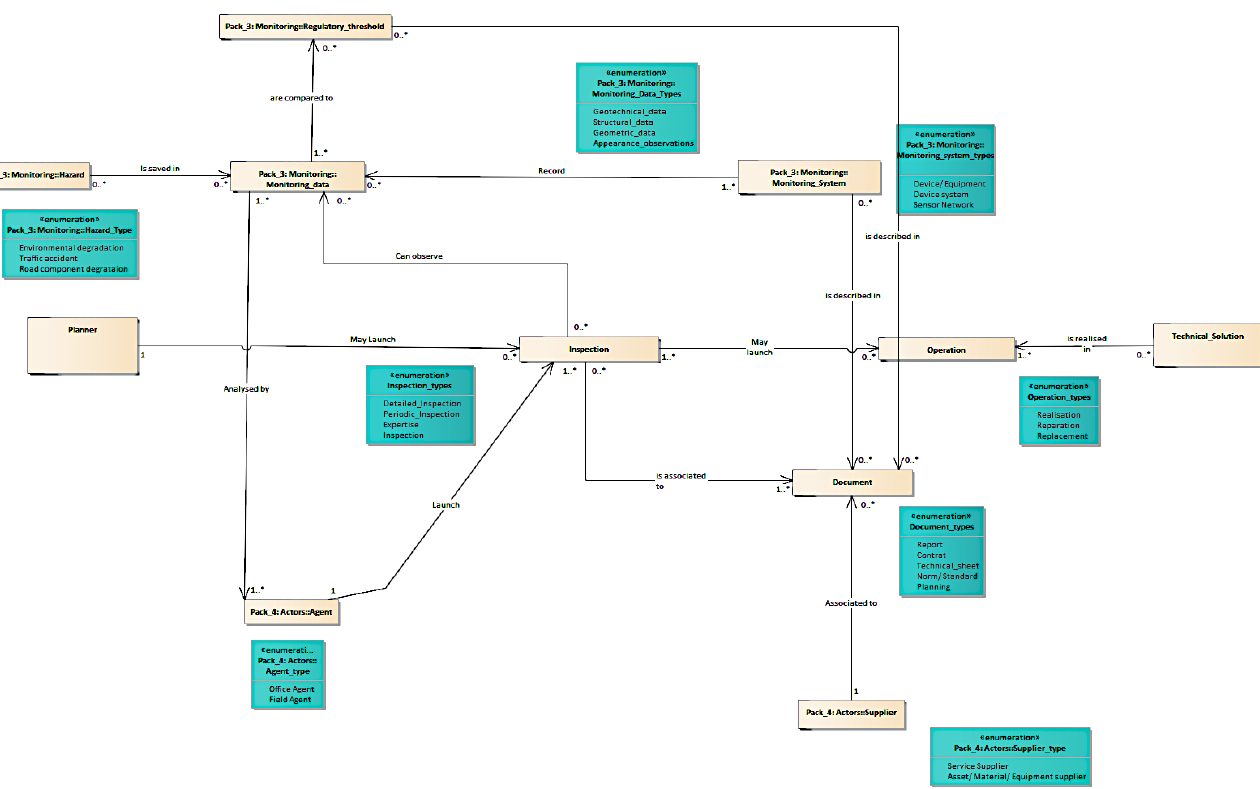
Figure 1. IFCInfra4OM ontology data model